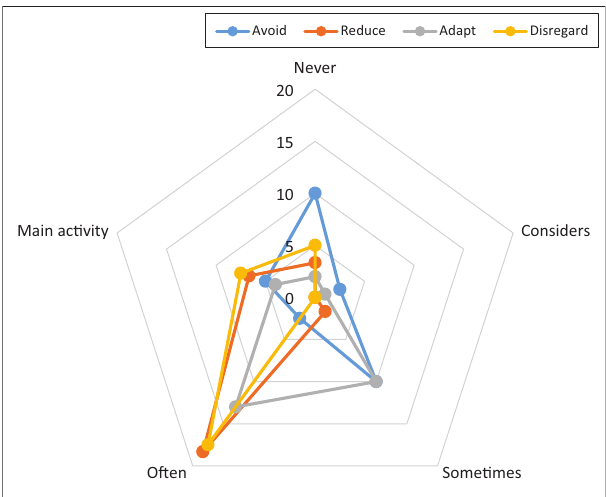
FIGURE 2: Response to regulatory uncertainty